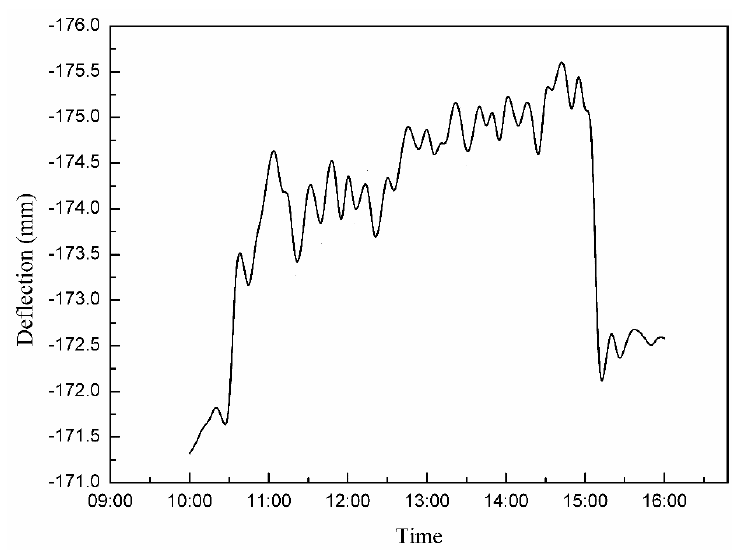
Figure 19. Change in the deflection of the long − span converter station steel structure.